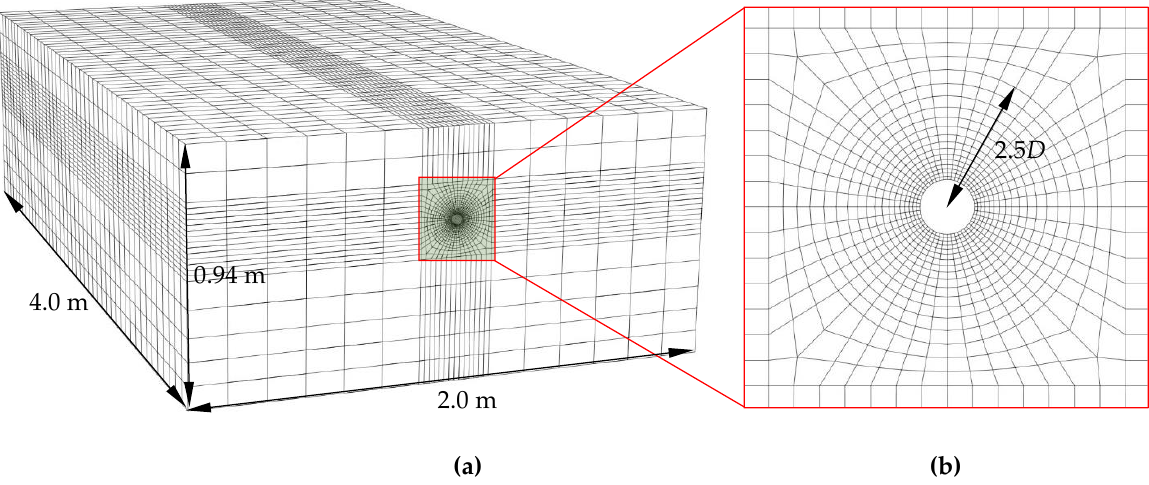
Figure 5. FE mesh of the pipe–soil system. ( a ) 3D FE mesh; and ( b ) cross-section near the pipe.